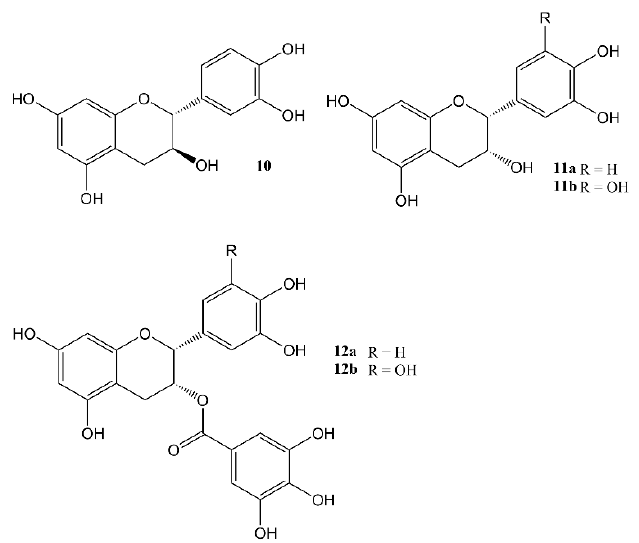
Figure 4. Catechins: 10 = catechin, 11a = Epicatechin, 11b = Epigallocatechin, 12a = Epicatechin gallate, 12b = Epigallocatechin gallate (EGCG) Proanthocyanidins are di-, tri, tetra-, or oligomers of these units.